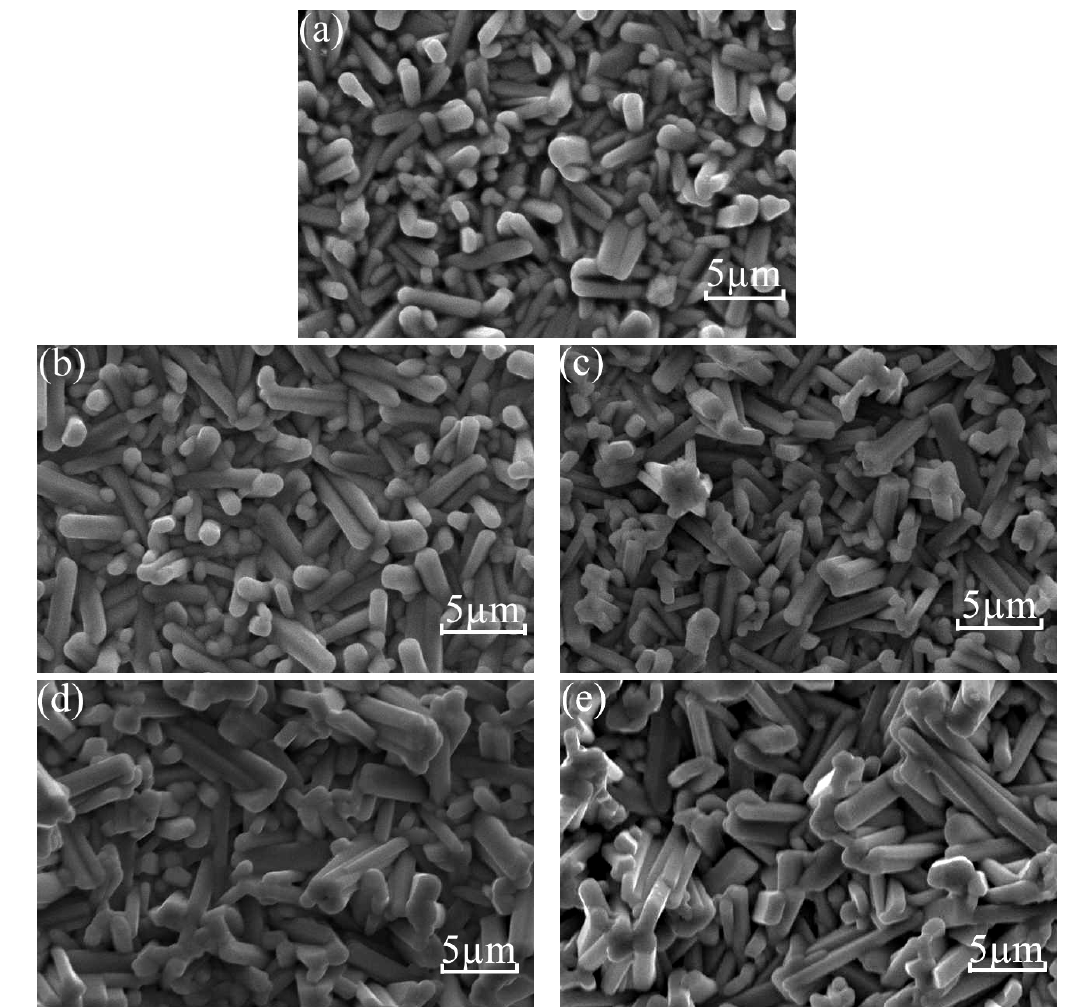
Fig. 2 SEM micrographs of (Ba 1 − x Sr x ) 4 (Sm 0.4 Nd 0.6 ) 28/3 Ti 18 O 54 ceramics with (a) x = 0.02, (b) x = 0.04, (c) x = 0.06, (d) x = 0.08, and (e) x = 0.1, sintered at 1440 ℃ for 4 h.